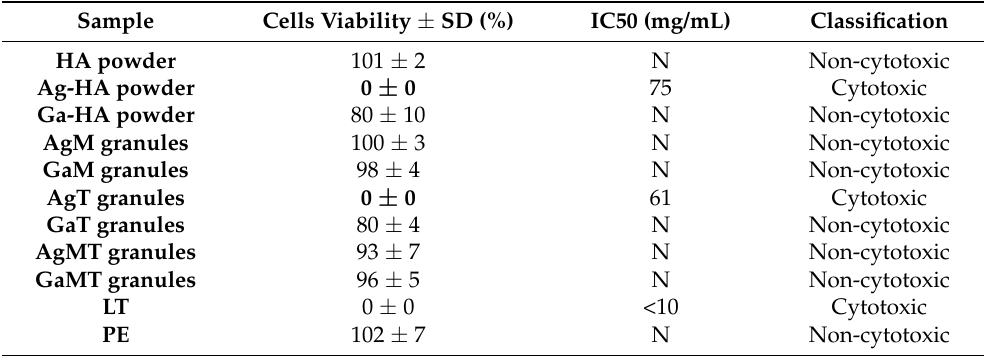
Table 3. Results of the neutral red uptake test for the highest concentrations of tested extracts (100 mg/mL) in comparison to the untreated